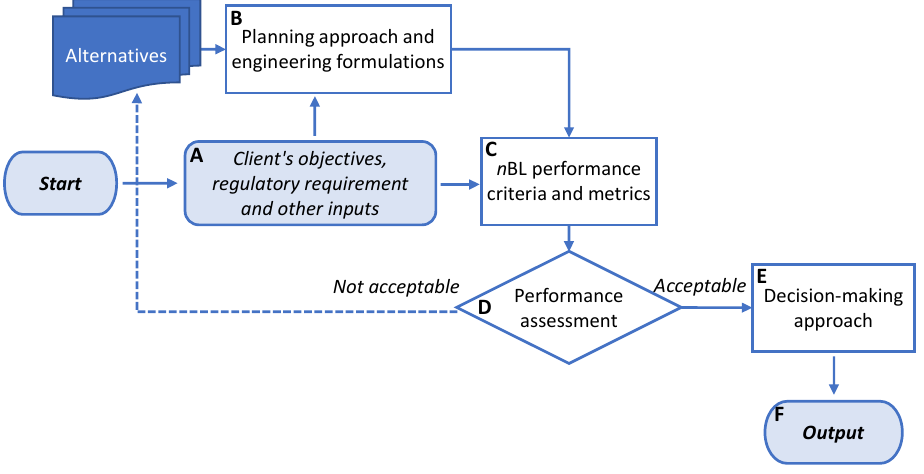
Figure 1. The main steps of the EMP framework, which was adopted from [3].